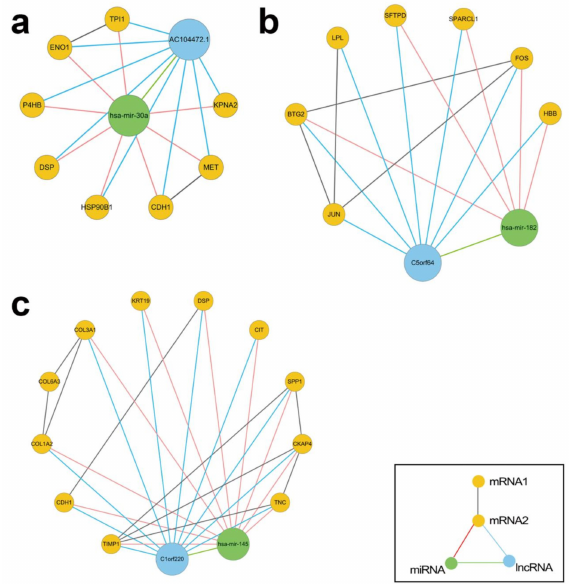
Figure 10. Three regulatory modules for lung adenocarcinoma. ( a ) regulatory module for lung adenocarcinoma a: hsa-mir-30a with its regulated lncRNA AC104472.1 and mRNAs, ( b ) regulatory module for lung adenocarcinoma b: hsa-mir-182 with its regulated lncRNA C5orf64 and mRNAs, and ( c ) regulatory module for lung adenocarcinoma c: hsa-mir-145 with its regulated lncRNA C1orf220 and